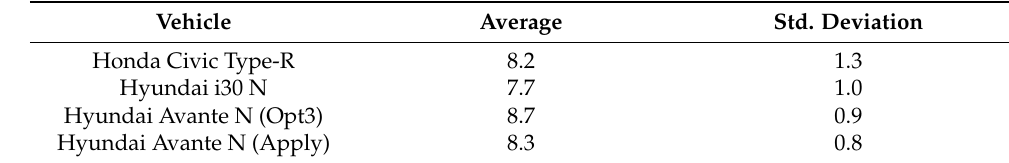
Table 1. Average and standard variation of scores by handling performance